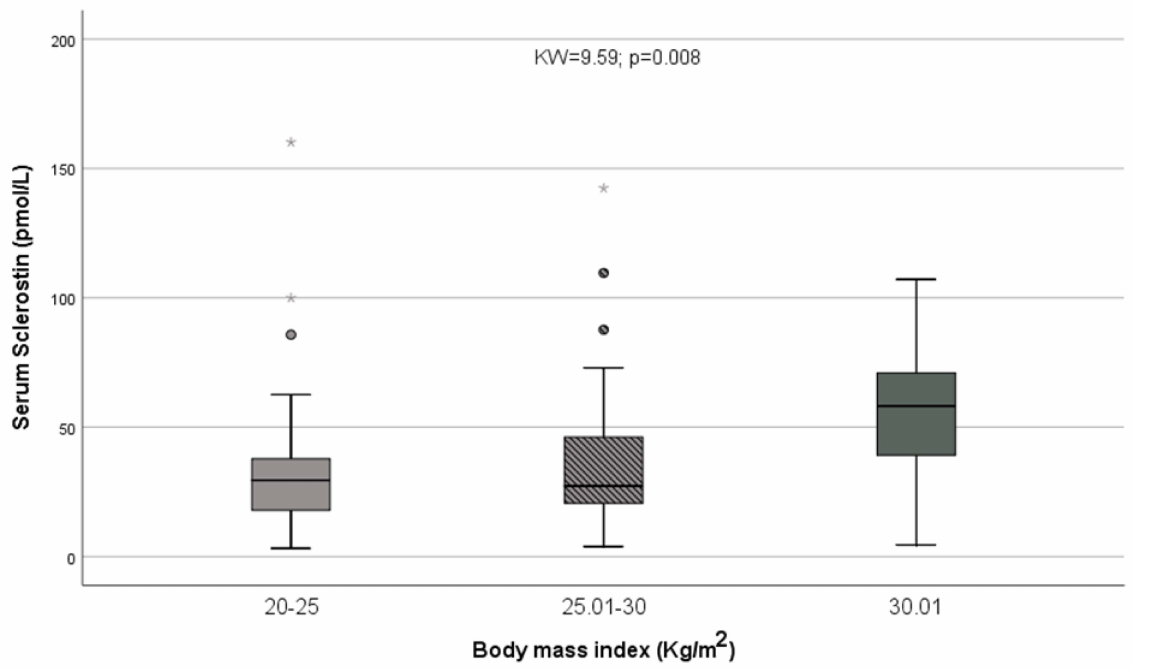
Figure 2. Obese patients (BMI > 30 kg/height 2 ) showed higher sclerostin levels than overweighted (BMI between 25.01 and 30 kg/height 2 ) and normal patients (BMI between 20 and 25 kg/height 2 ). * = represent extreme values.